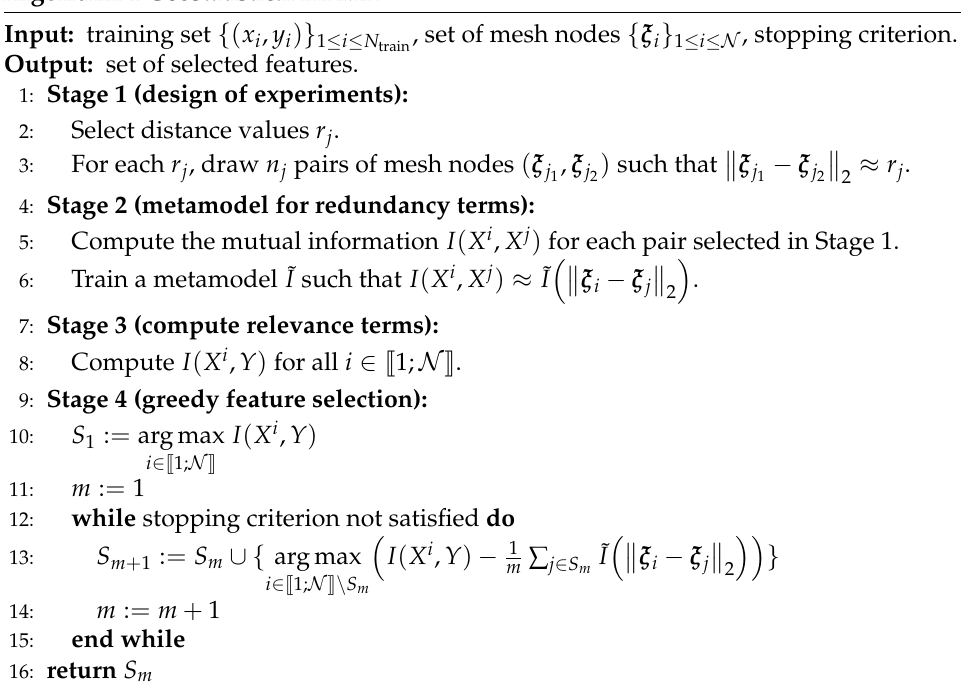
Algorithm 1 Geostatistical